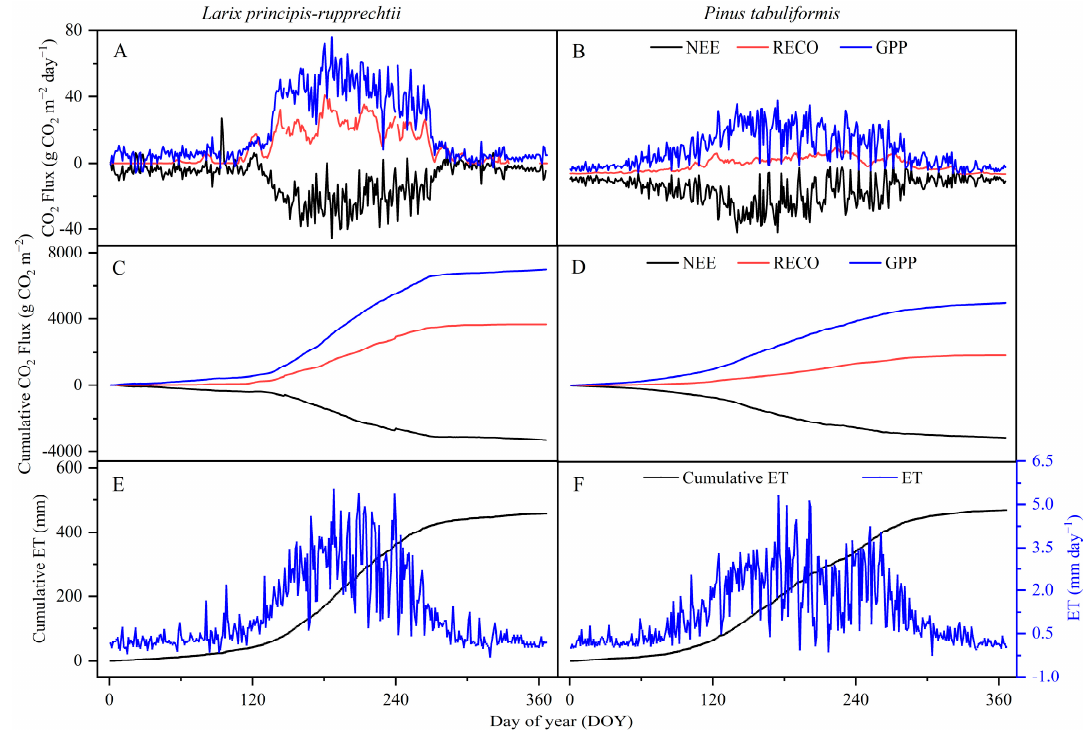
Figure 2. Temporal variations of daily CO 2 fluxes (net ecosystem exchange (NEE), ecosystem respiration (RECO), gross primary production (GPP)) ( A , B ), cumulative CO 2 fluxes (NEE, RECO, GPP) ( C , D ), daily and cumulative H 2 O flux ( E , F ) (evapotranspiration (ET)) in two forest ecosystems.